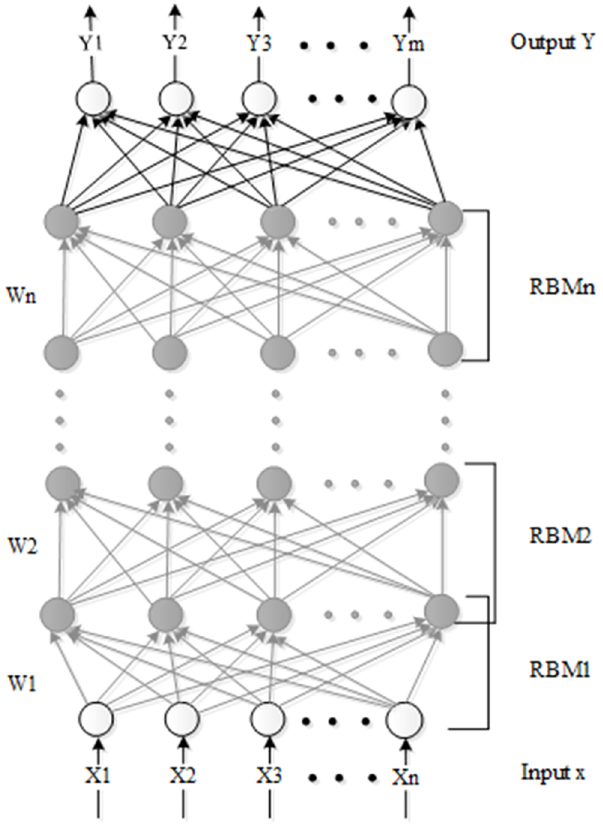
Fig 4. The topology of DBN network used in our article. The DBN network can not only solve a complex nonlinearproblembut also extract more features from high-dimensionaldata. The DBN network is composed of an input layer, hiddenlayers, and an output layer. The DBN structure that is used in our article is presented in Fig